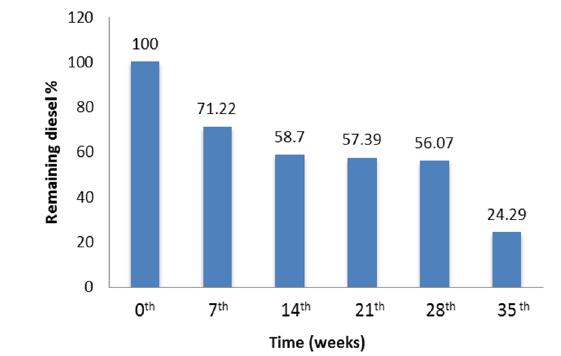
Fig. 3. Percentage of remaining diesel through remediation time in amended soil .